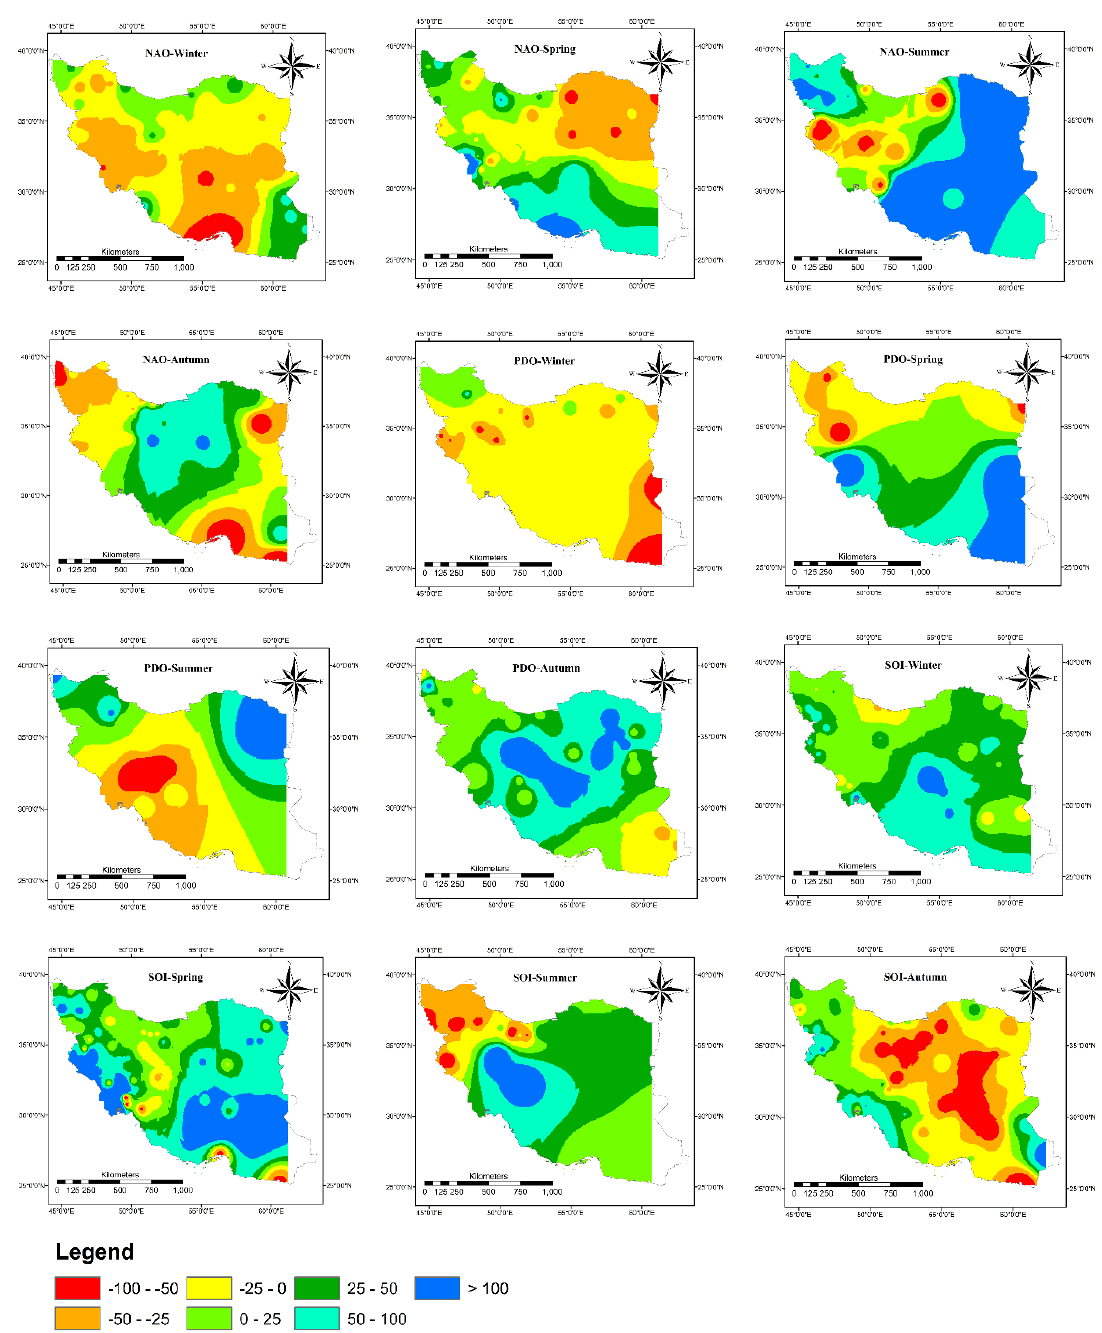
Figure 6. Total change in precipitation due to the effect of SOI, NAO, and PDO in the range of x < − 2, where x denotes the SOI, NAO, and PDO value.